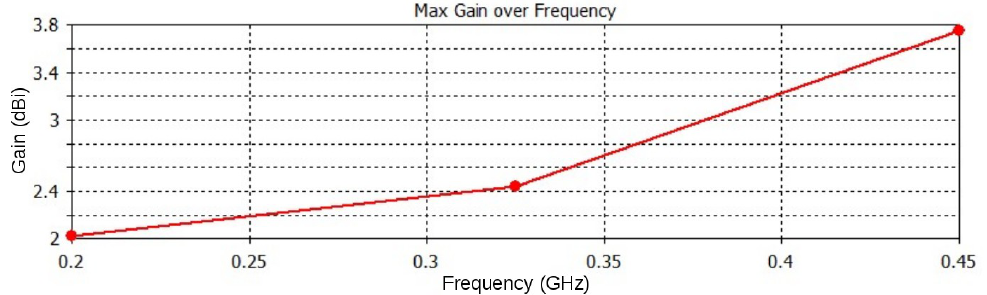
Figure A7. Maximum gain as a function of